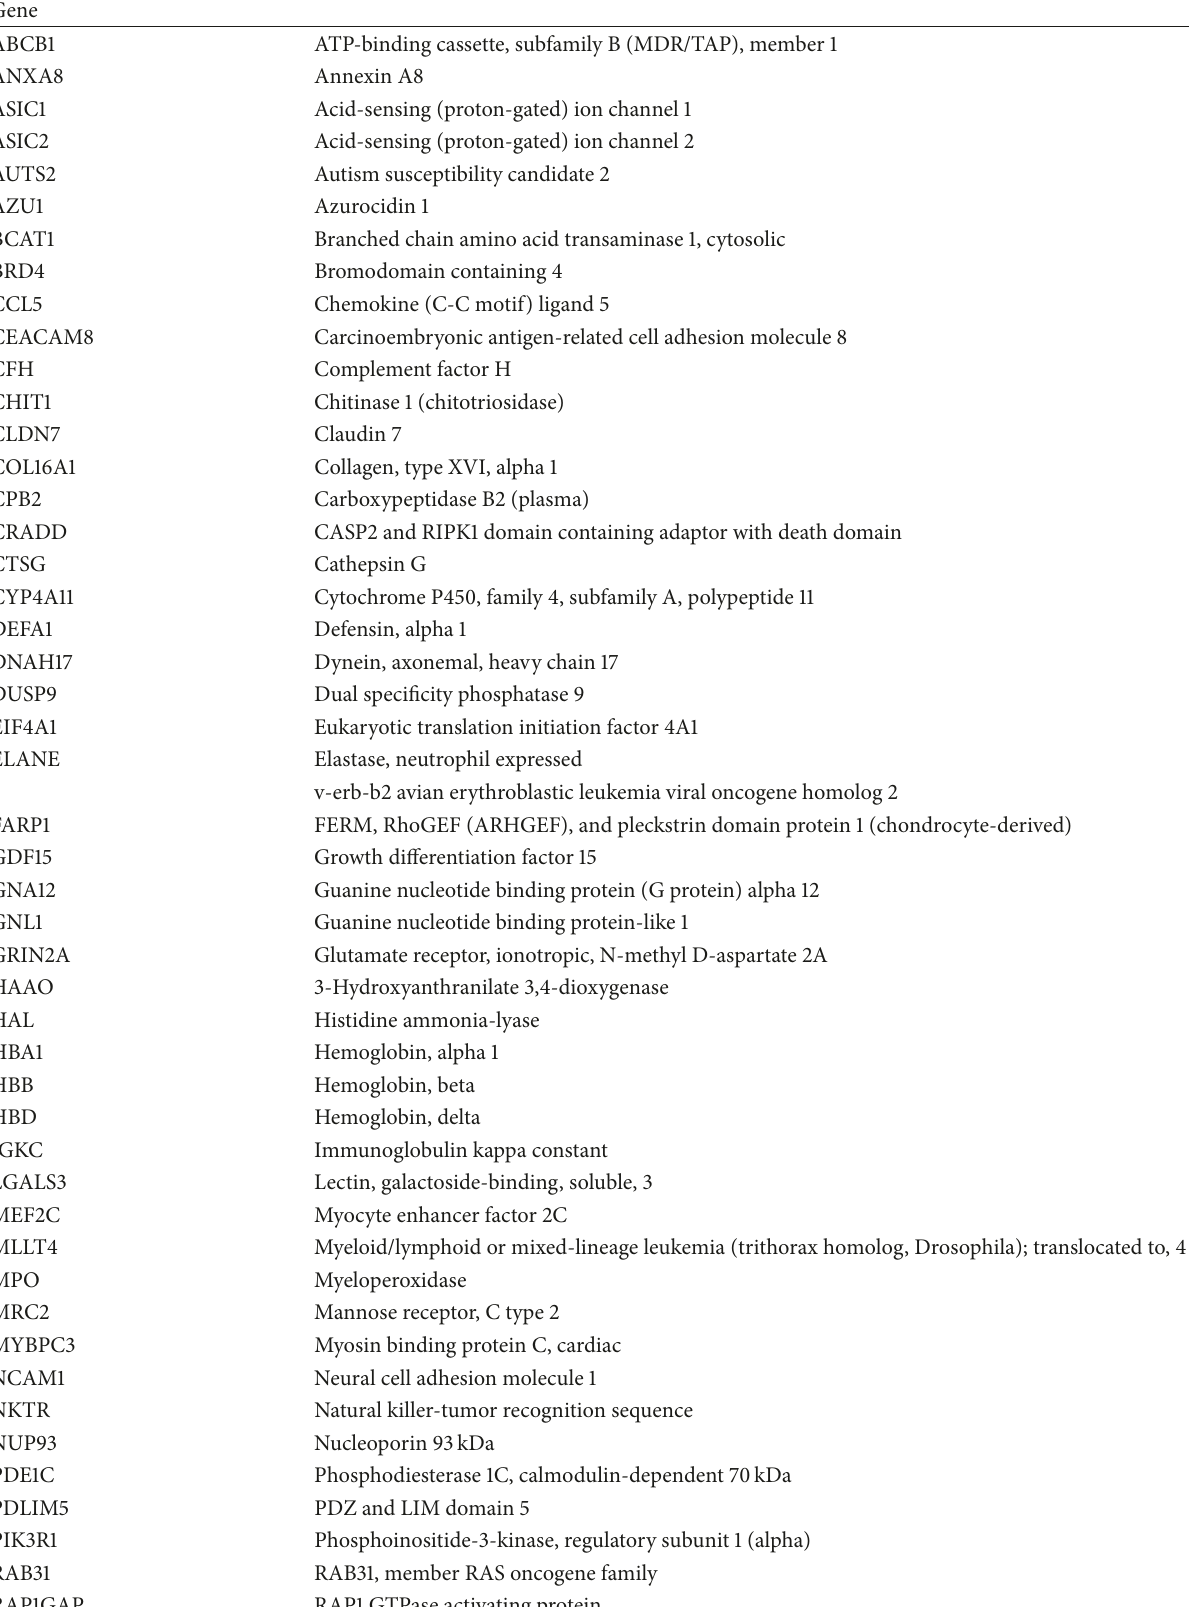
Table 9: Overlapping EV proteins from HIV+ and HIV − samples, LC/MS/MS